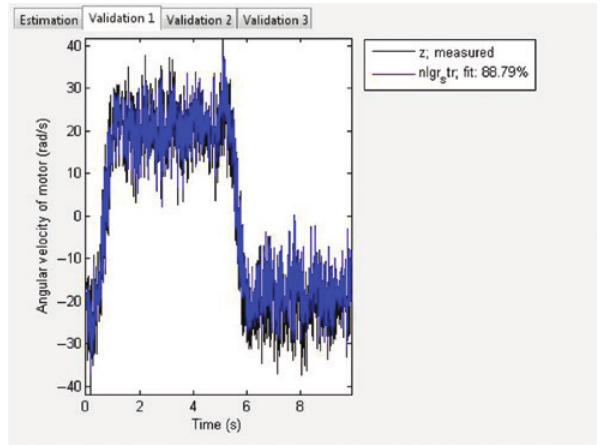
Figure 3: Fitness Value (2) of Motor.